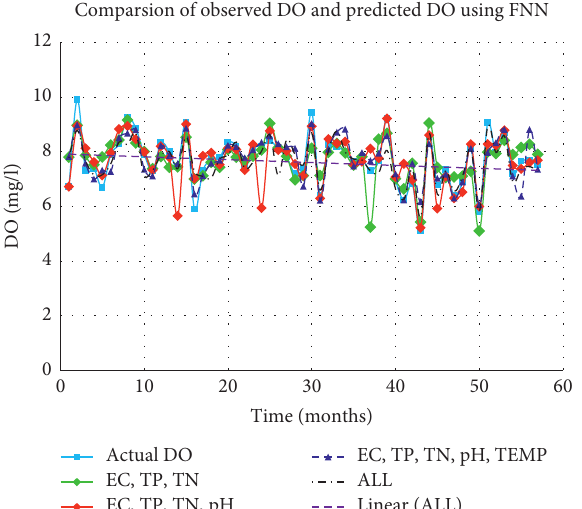
Figure 11: Observed DO and FNN-predicted DO for all the input samples within the basin (the ALL trend is for LULC and water quality parameters and its linear estimation is the Linear